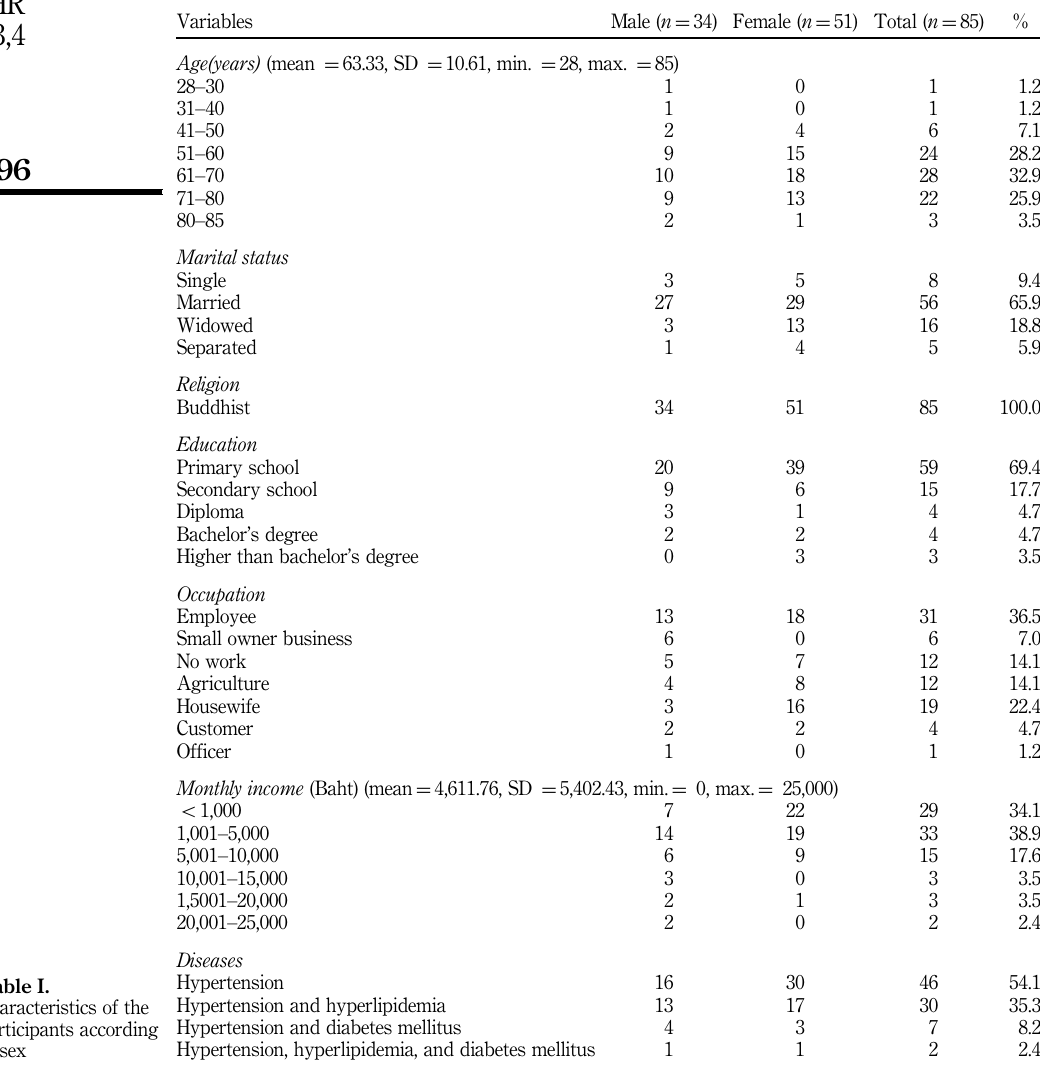
Table I. Characteristics of the participants according to